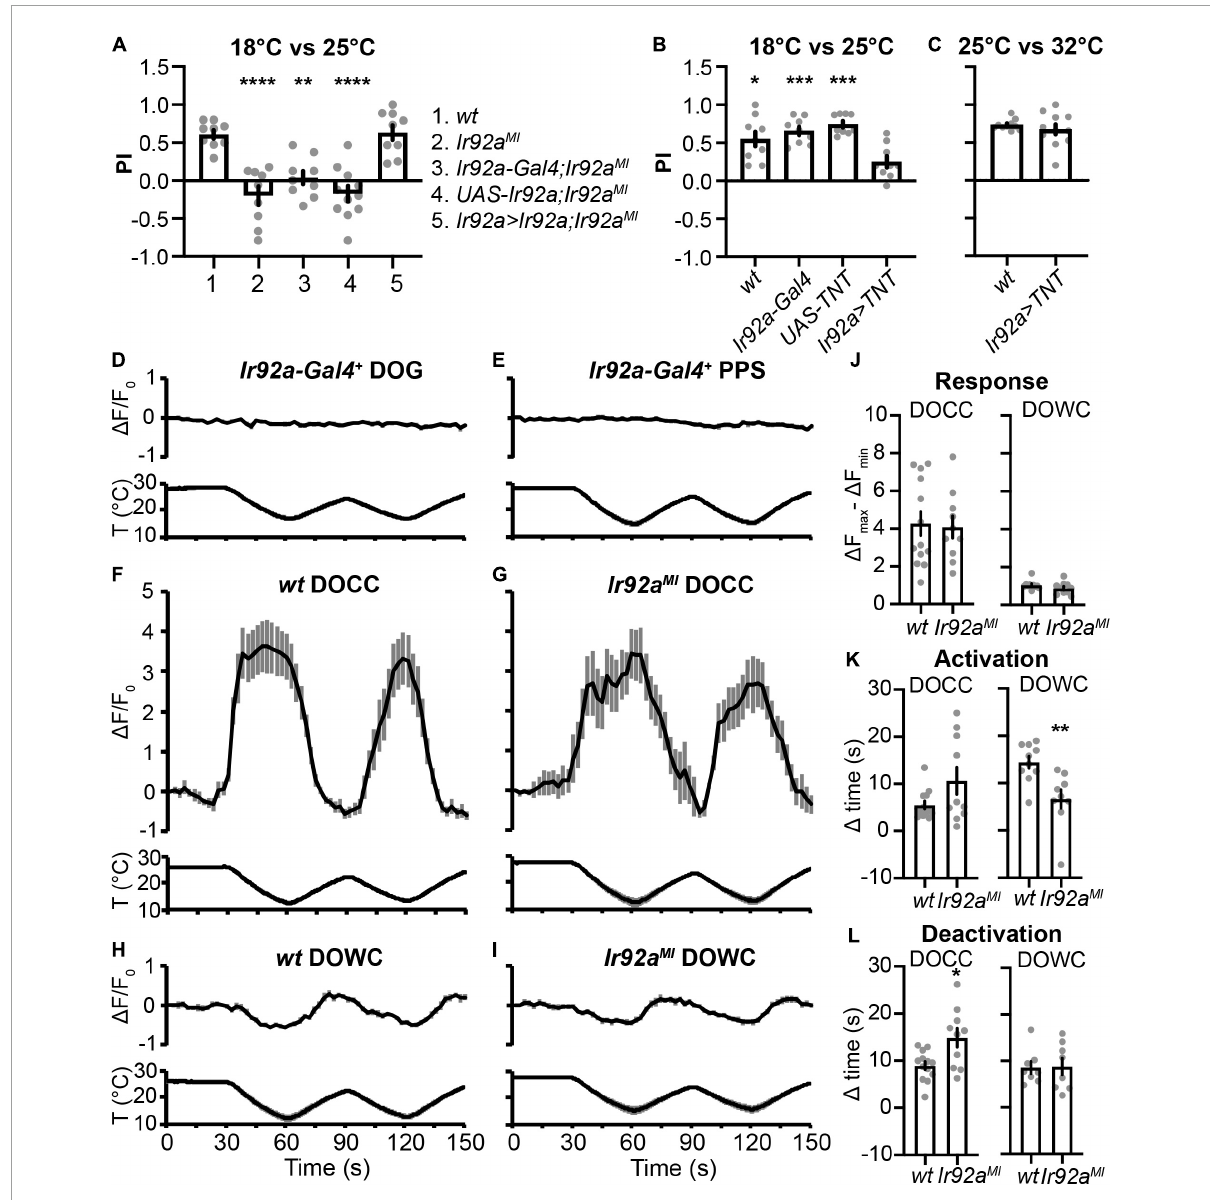
FIGURE5 The role of IR92a in cool preferences between 18 ◦ C and 25 ◦ C. (A) IR92a is necessary for cool preferences between 18 ◦ C and 25 ◦ C. n = 9–11; data represent means ± s.e.m; ** P < 0.01 and **** P < 0.0001, the Ordinary one-way ANOVA test followed by the Tukey test. Ir92a > Ir92a,Ir92a MI : Ir92a-Gal4,Ir92a MI /UAS-Ir92a,Ir92a MI . (B,C) Ir92a-Gal4 positive cells are necessary for cool preferences between 18 ◦ C and 25 ◦ C, but not between 25 ◦ C and 32a. n = 9–11; data represent means ± s.e.m; * P < 0.05 and *** P < 0.001, comparing to Ir92a > TNT ( UAS-TNT; Ir92a-Gal4 ), the Welch’s test, except the Mann–Whitney test for the comparison of UAS-TNT and Ir92a > TNT in (B) . The same set of UAS-TNT data was used as in Figure 3C . wt : CS. (D–I) Calcium changes in response to temperature fluctuations of indicated genotypes and cells. Fluorescence is quantified as the percent change in fluorescence intensity compared to initial intensity. n = 9–13; data represent means ± s.e.m. Genotypes: (D,E) Ir92a-Gal4; UAS-GCaMP6m ; (F) Ir21a-Gal4; UAS-GCaMP6m ; (G) Ir21a-Gal4; UAS-GCaMP6m,Ir92a MI ; (H) Ir93a-Gal4;Ir21a-Gal80/UAS-GCaMP6m ; (I) Ir93a-Gal4; Ir21a-Gal80, Ir92a MI /UAS-GCaMP6m, Ir92a MI . (J–L) The role of IR92a in calcium responses of DOCCs (F,G) and DOWCs (H,I) . n = 8–13; data represent means ± s.e.m; * P < 0.05 and ** P < 0.01, the Welch’s test was applied to DOCCs’ response, DOWCs’ activation time, and DOCCs’ deactivation time; the Mann-Whitney test was applied to DOWCs’ response, DOCCs’ activation time, and DOWCs’ deactivation time.